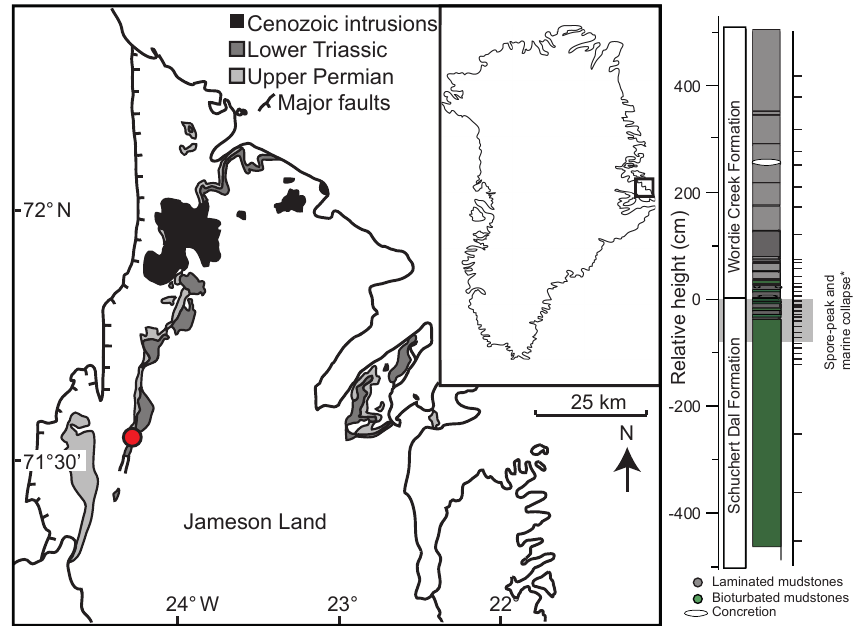
Figure 1. Map of Jameson Land, East Greenland (adapted from Piasecki, 1984). The location of the studied section is indicated with a red circle. The right panel shows the lithology of the studied section and sample depths. (* is the spore peak after Looy et al., 2001; marine collapse after Twitchett et al.,